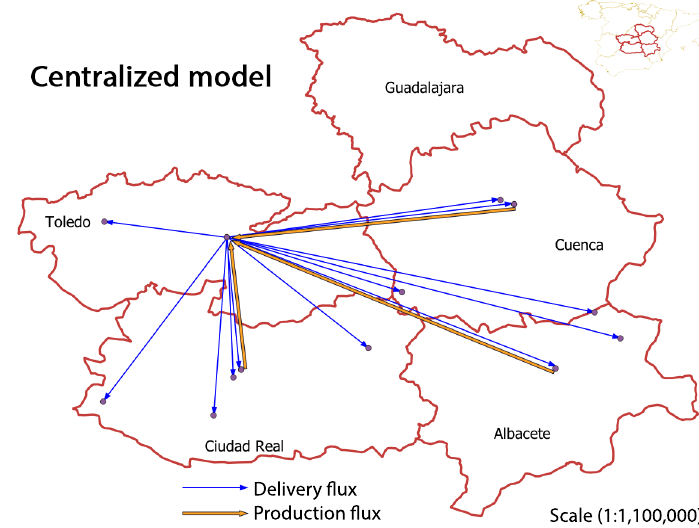
Figure 9. Flux map of the face shields production (orange arrows) and deliveries (blue arrows) from the central distribution model. Table 4. PPE destinations for centralized and decentralized models.